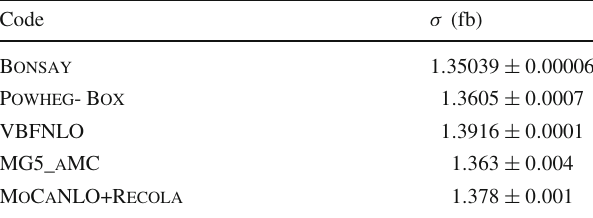
Table 5 Cross sections at NLO accuracy and order O (α s α 6 ) . The pre- dictions are obtained in the fiducial region described in Sect. 3.3. The uncertainties shown refer to estimated statistical errors of the Monte Carlo